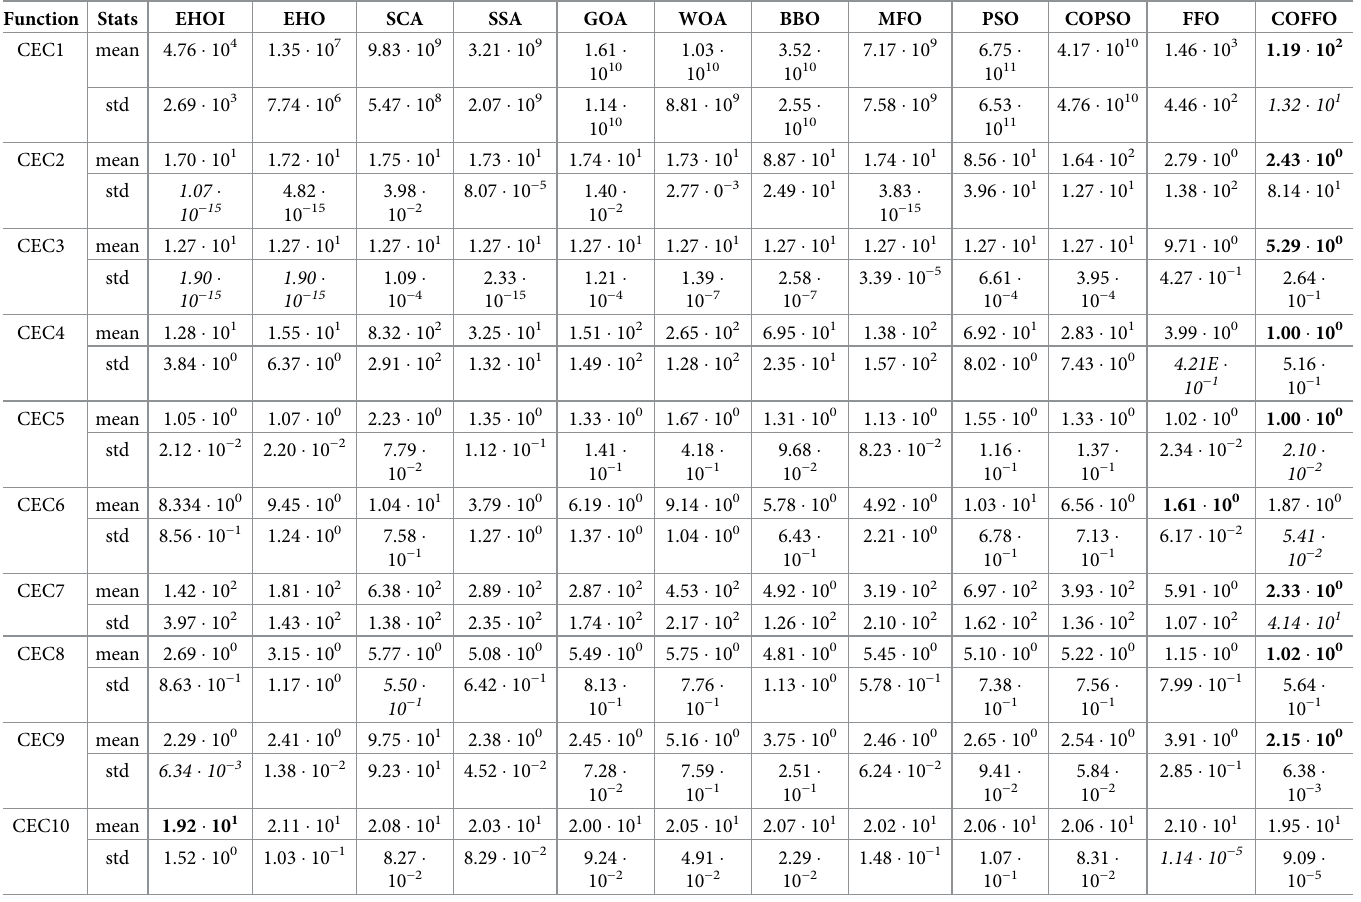
easier reading. The obtained results of EHO, EHOI, SCA, SSA, GOA, MFO, PSO, WOA and BBO are slightly different from the results in the paper [52] due to the stochastic nature of observed algorithms. From the results in Table 3, it is apparent that the presented method outperformed other tested algorithms. COFFO has the best mean value regarding eight functions (CEC1, CEC2, CEC3, CEC4, CEC5, CEC7, CEC8 and CEC9). The original FFO achieved the best mean value on CEC6 test instance, followed by COFFO. EHOI performed best on function CEC10, mar- ginally in front of COFFO. COPSO obtained a better mean fitness value than the original PSO on seven functions due to chaotic opposition-based initialization. The new COFFO is promi- nent on CEC1 and CEC2 test instances in comparison to other algorithms. Table 3. Mean fitness and standard deviation results of compared approaches on CEC2019 benchmark functions. Function Stats